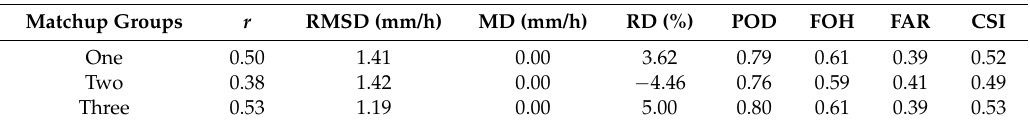
Table 3. Metrics calculated between GPM DPR and TRMM PR.